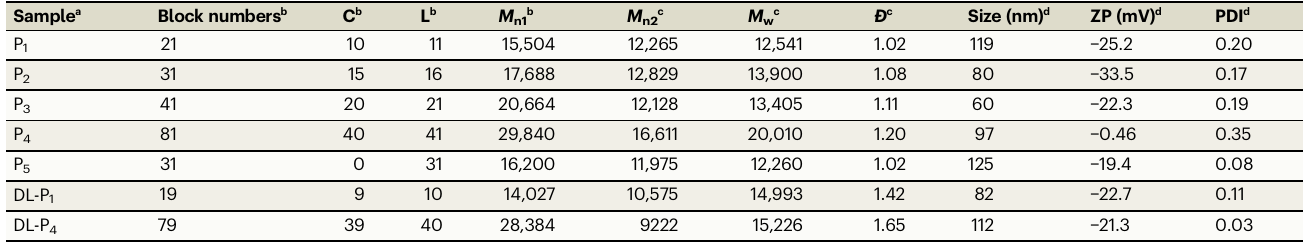
Table 1 | Characteristics of polyureas and their assemblies